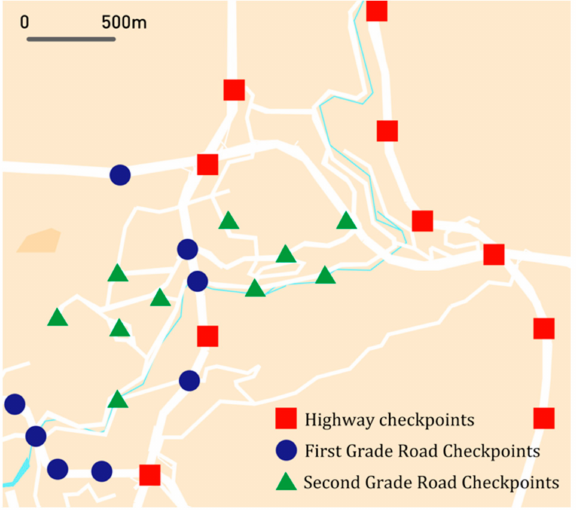
Figure 2. Classification of location information of video surveillance camera according to the grade of